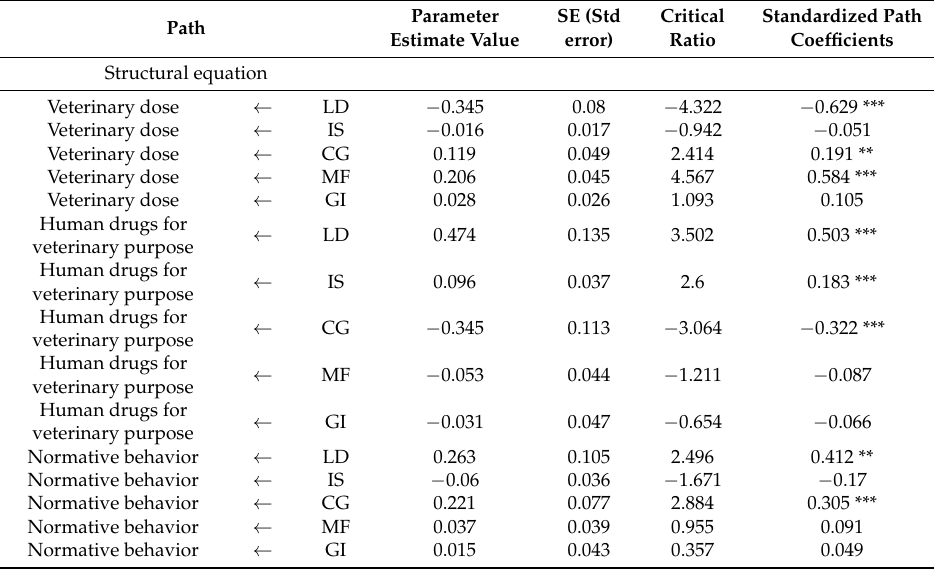
Table 7. Structural coefficient table of structural equation model. (Please define the symbols “**” and “***” and explain the abbreviations we